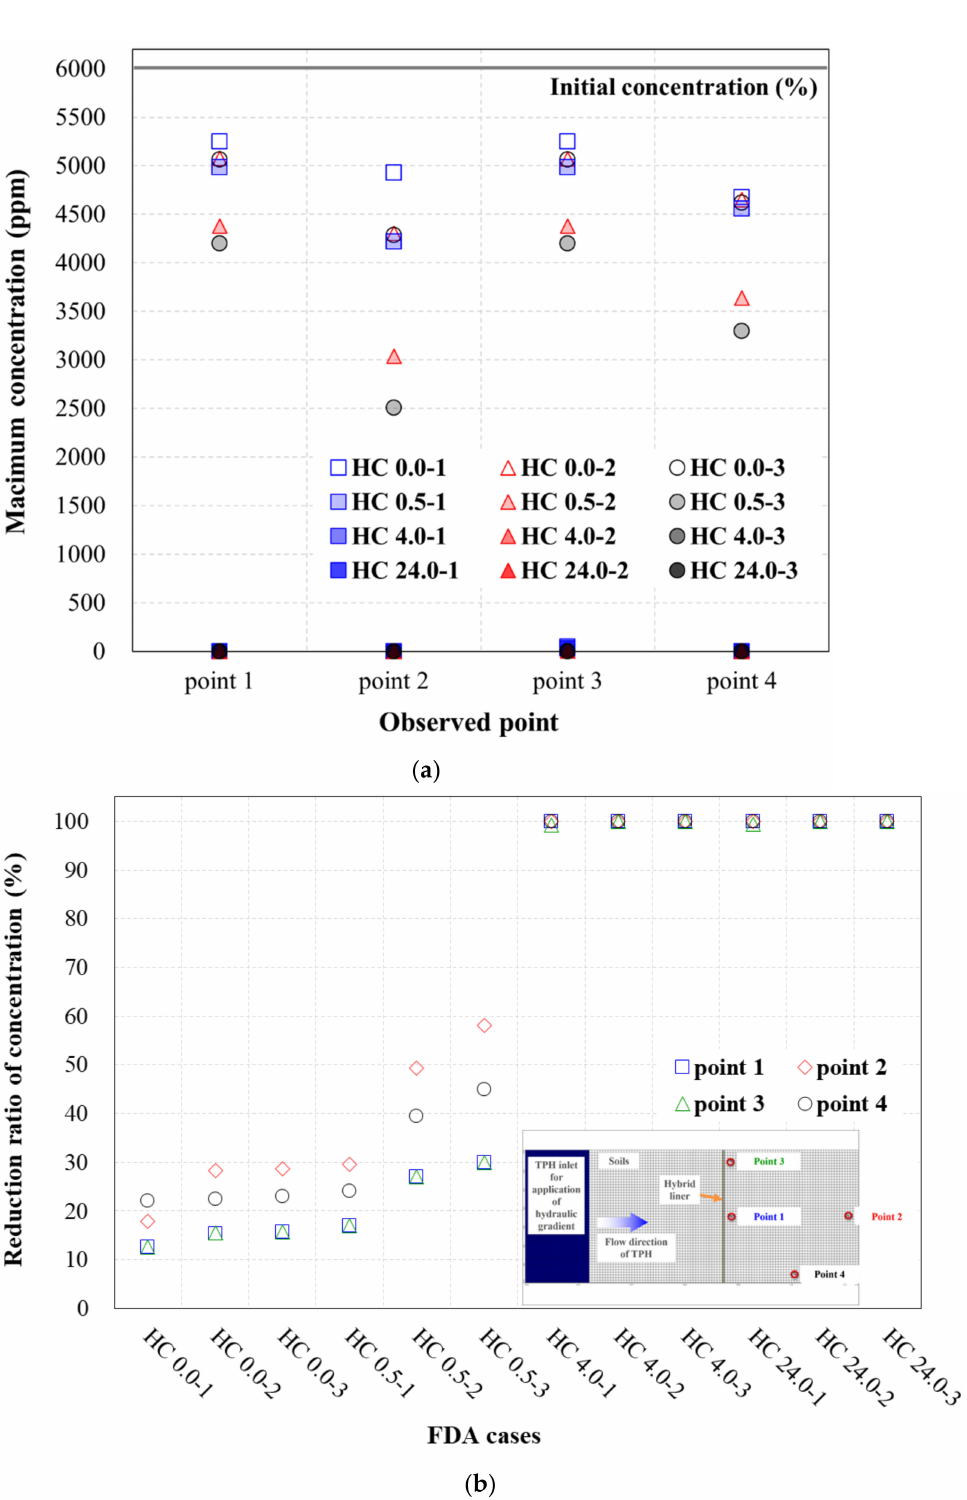
Figure 6. Concentration variance at the high-TPH condition: ( a ) Maximum concentration (ppm) at the observation point; ( b ) Reduction ratio of the concentration at the observation